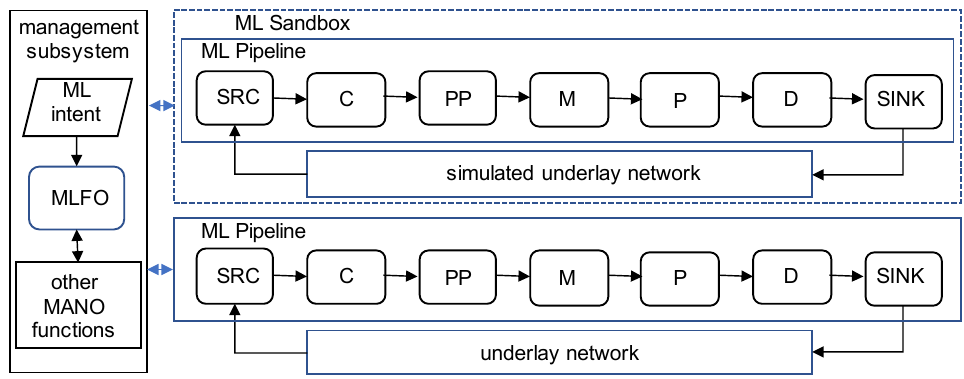
Figure 4. ITU-T unified architecture for ML in future